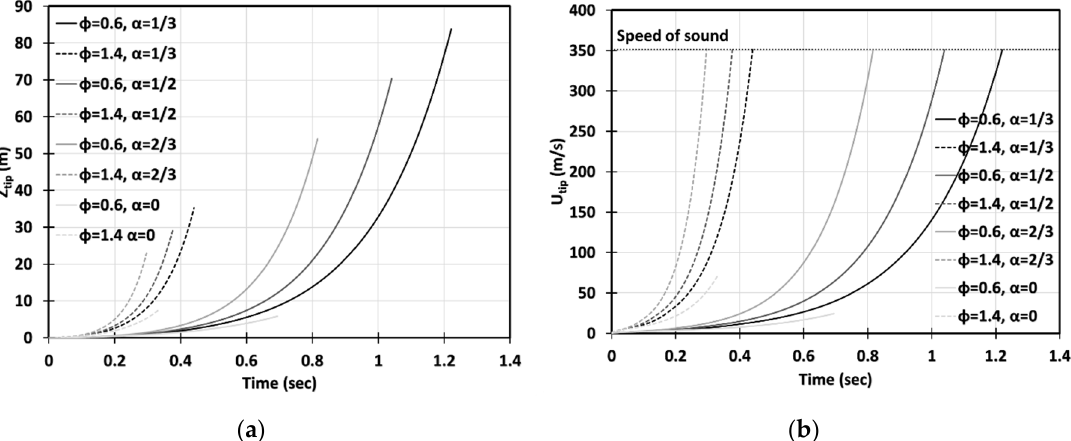
( b ) Figure 6. Time evolution of the flame tip position (cid:1852) (cid:3047)(cid:3036)(cid:3043) ( a ) and velocity (cid:1847) (cid:3047)(cid:3036)(cid:3043) ( b ) in a 2D geometry for lean ( (cid:2038) = 0.8 ), stoichiometric ( (cid:2038) = 1 ), and rich ( (cid:2038) = 1.2 ) CH 4 -air burning with various blockage ratios (cid:2009) = 0, 1 3,⁄ 1 2,⁄ 2 3⁄ . The flame will propagate slower if we deviate further from stoichiometry, as depicted in Figure 7, showing the evolutions of the position and velocity of the (cid:2038) = 0.6 and (cid:2038) = 1.4 methane-air flames (to avoid messy, we split the plots for various equivalence ratios between Figures 6 and 7). It is also seen that the duration of acceleration of the highly lean/rich flames in Figure 7 exceeds that of the stoichiometric or slightly lean/rich flames in Figure 6. In particular, without obstructions, the (cid:2038) = 0.6 flame stops accelerating after advancing 5.8 m and attaining the maximal velocity of 24.6 m/s , before the flame skirt contacts the wall. Obviously, this acceleration scenario does not end thereafter, if the obstacles are added to the passage wall. In contrast, the flame front will keep accelerating until its speed reaches the speed of sound and, eventually, the detonation is triggered. It is noted that the obstacles facilitate flame acceleration as compared with that in an unobstructed passage, and the impact of obstacles seems to be more important for the (cid:2038) = 0.6 flames than for the (cid:2038) = 1.4 flames: